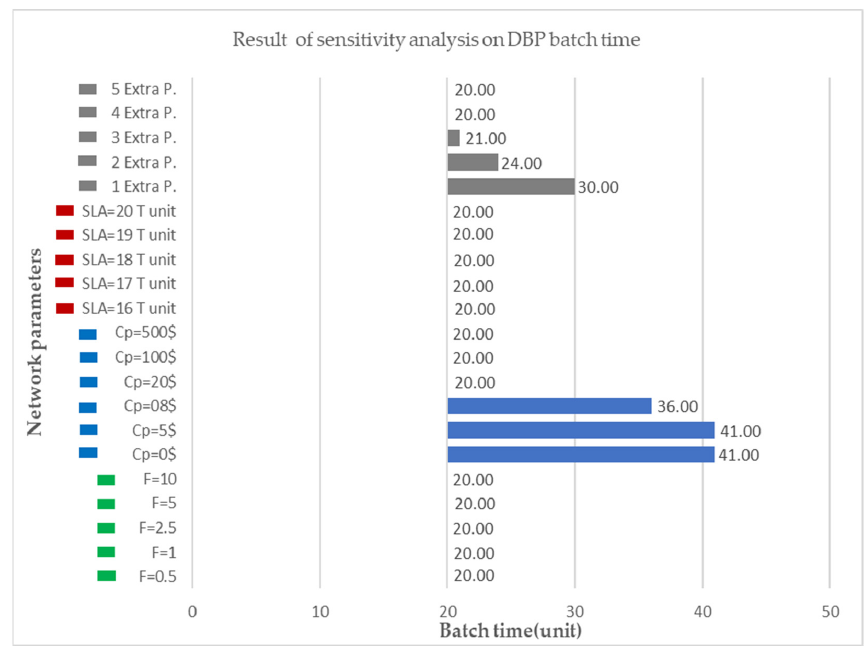
Figure 5. Result of sensitivity analysis on DBP batch